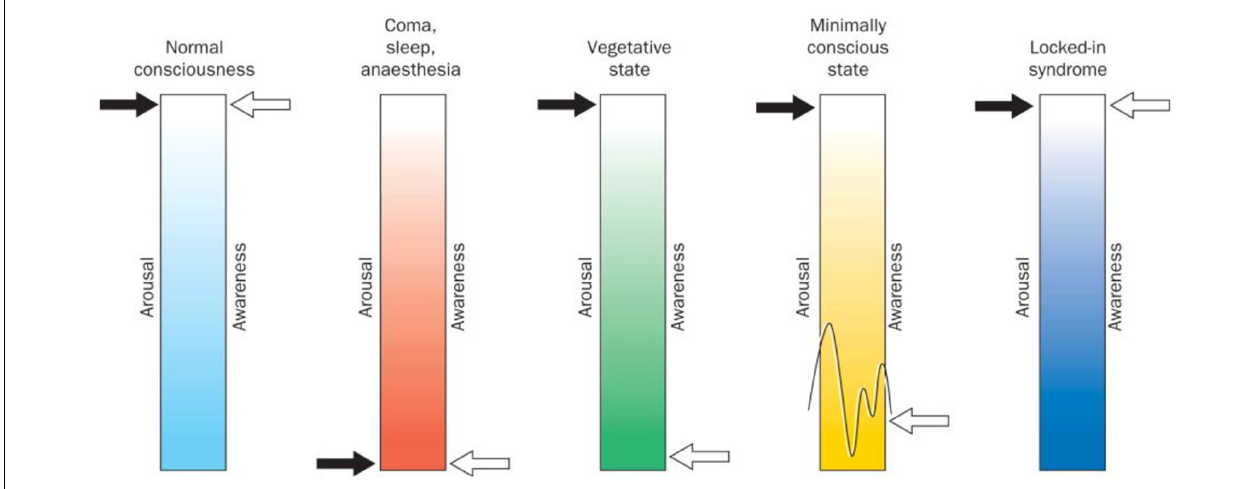
FIGURE 1 | Arousal (wakefulness) vs. awareness in disorders of consciousness and locked-in syndrome. Normal consciousness is categorized by high levels of arousal and awareness. On the other hand, comatose state, sleep, and deep anaesthesia are categorised by the absence of all signs of arousal and awareness. Vegetative state (VS) is defined as wakefulness without any signs of awareness, while minimally conscious patients show high levels of arousal and experience some signs of awareness that are present albeit inconsistent. Finally, locked-in patients show high levels of arousal and awareness similar to normal consciousness but lack most physical and verbal ability to interact with their environment. Figure retrieved from Laureys et al.